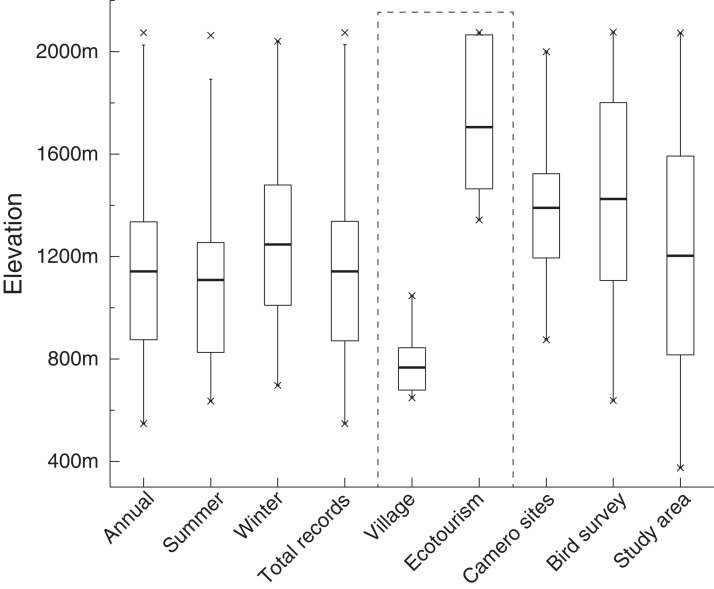
Samples effected in our research.Dash line highlights human influence in this study. On the left side of dash line, the elevation range for occurrence points for three groups were presented, while elevation range for our survey and study area were shown in the right side.